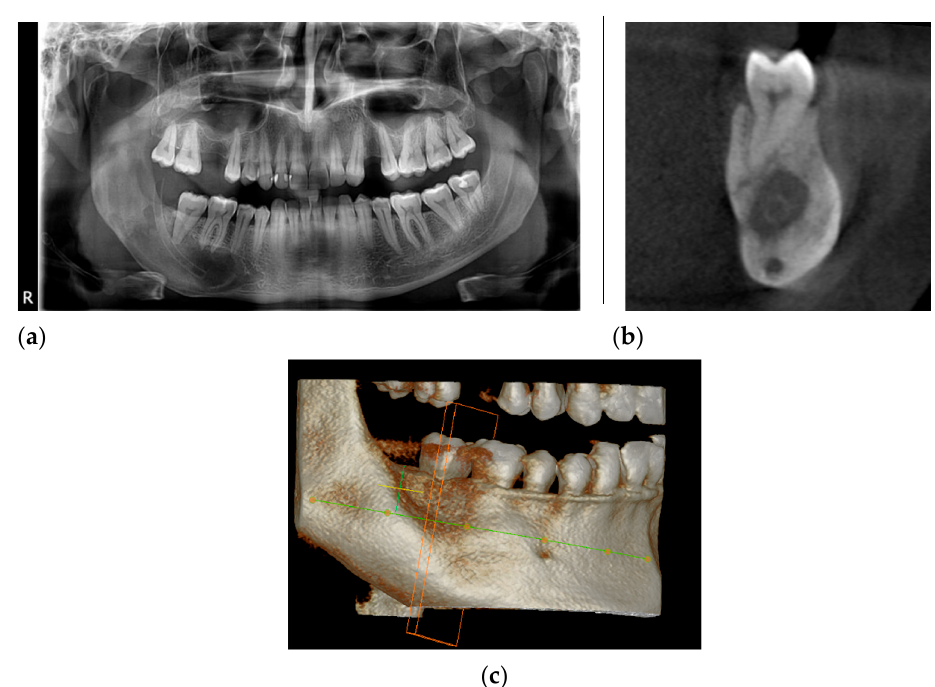
Figure 4. The radiological aspect after one year of decompression: ( a ) panoramic radiography shows a reduction in the size of the cyst; ( b ) the CBCT, coronal view indicates the position of the tube in the cyst cavity; ( c ) the CBCT, 3D reconstruction view.